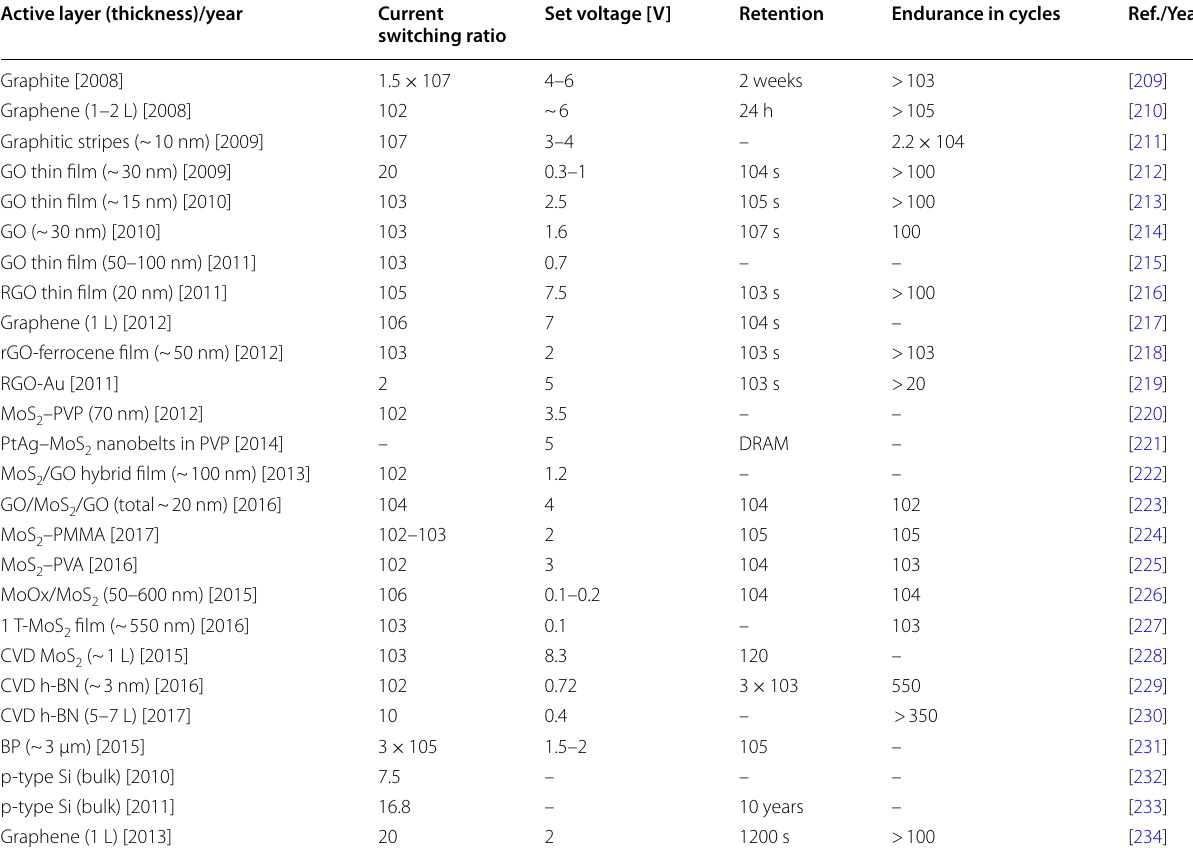
Table 1 2D material-based non-volatile memory devices and their performance Active layer (thickness)/year Current Set voltage [V] Retention Endurance in switching ratio